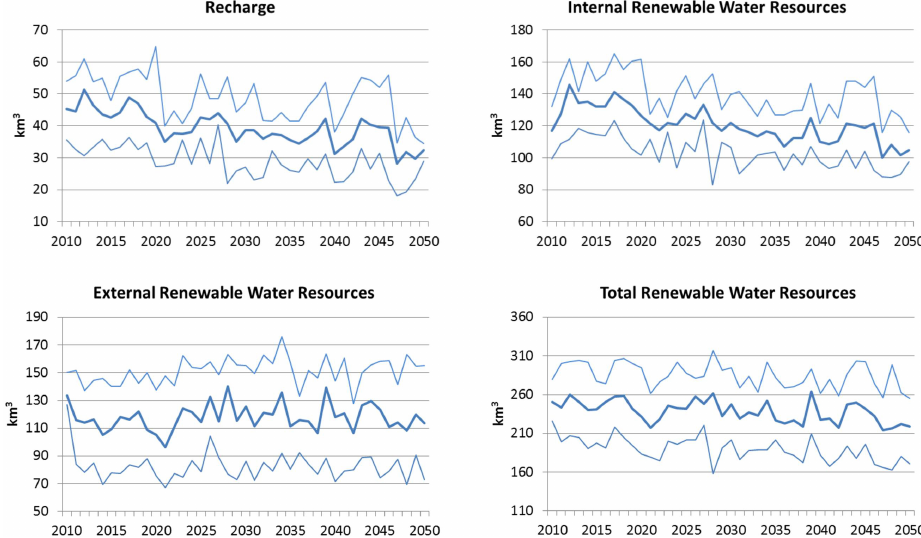
Fig. 7. Total gross recharge, internal, external and total renewable water resources from 2010 to 2050. The thick line is the average of the nine GCMs, and the thin lines show the second wettest and second driest GCM.